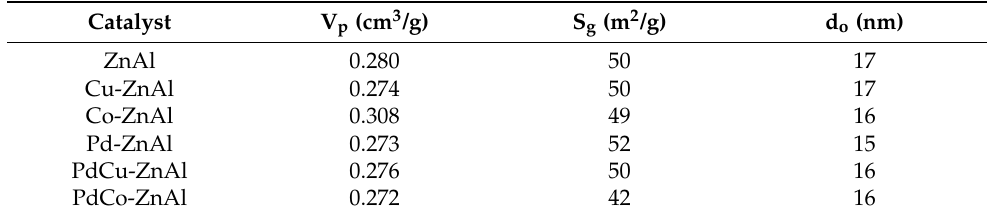
Table 1. BET surface area (S g ), pore volume (V p ) and pore diameter (d 0 ) of support and catalysts. Catalyst V p (cm 3 /g)